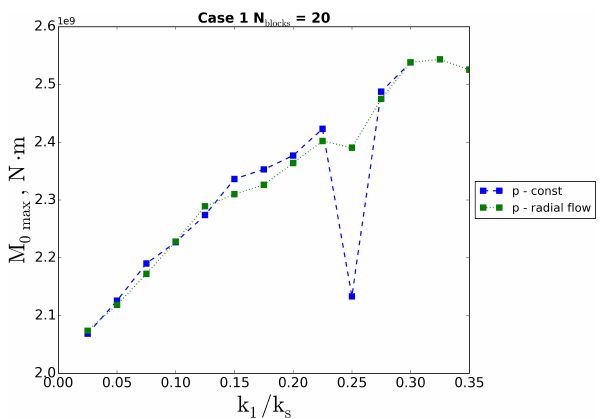
Figure 18. The event maximum seismic moment dependence on the stiffness of the interblock link.